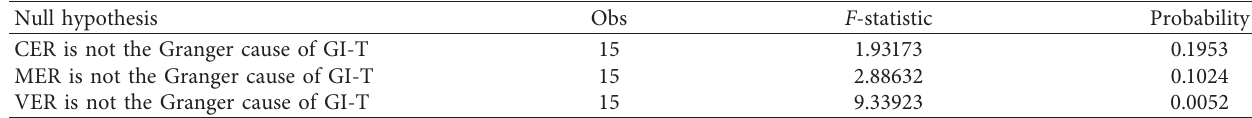
Table 5: Granger causality test results (the lag period is 2 years).